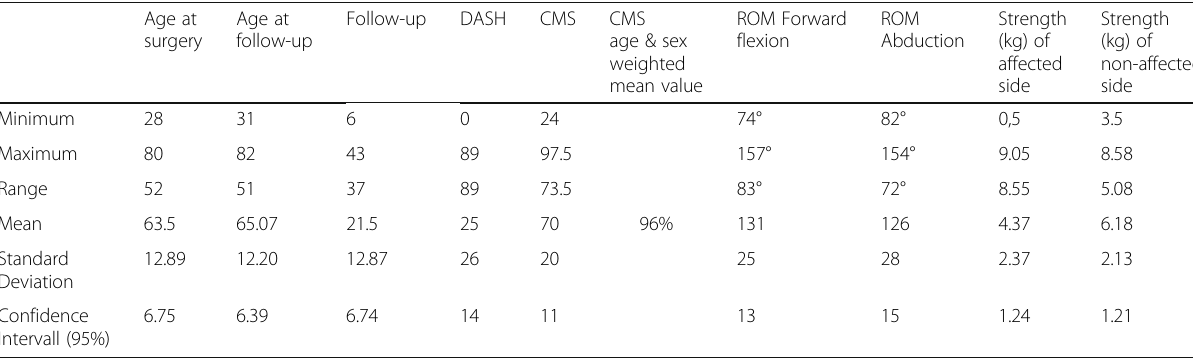
Table 2 Functional results after stabilisation of humerus fractures using the portal of Neviaser Age at